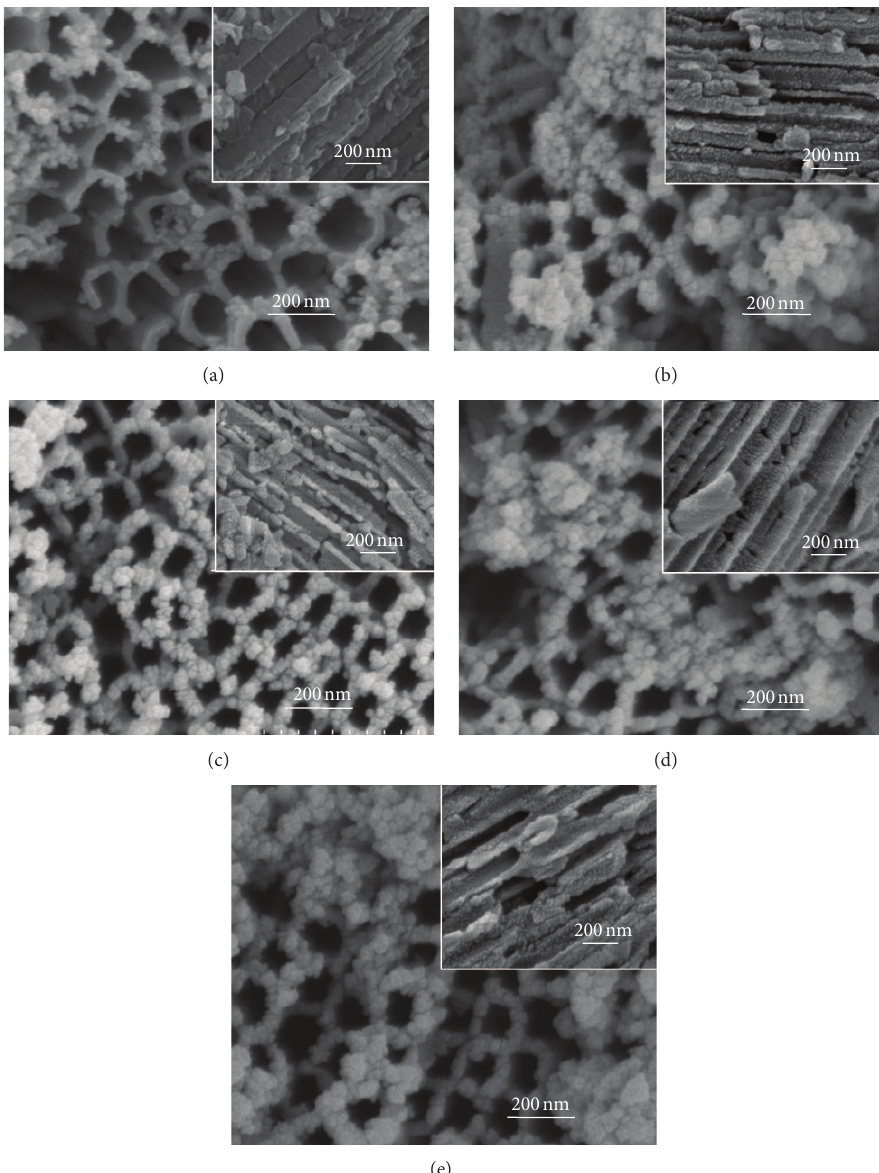
Figure 2: (a) Top-view and side-view images of the CdS/TNAs and the TNAs modified by (b) TiCl 4 , (c) HNO 3 , (d) KOH, and (e) MTMS. the nanotube wall of the reference sample without surface treatment. Compared with the reference sample, many